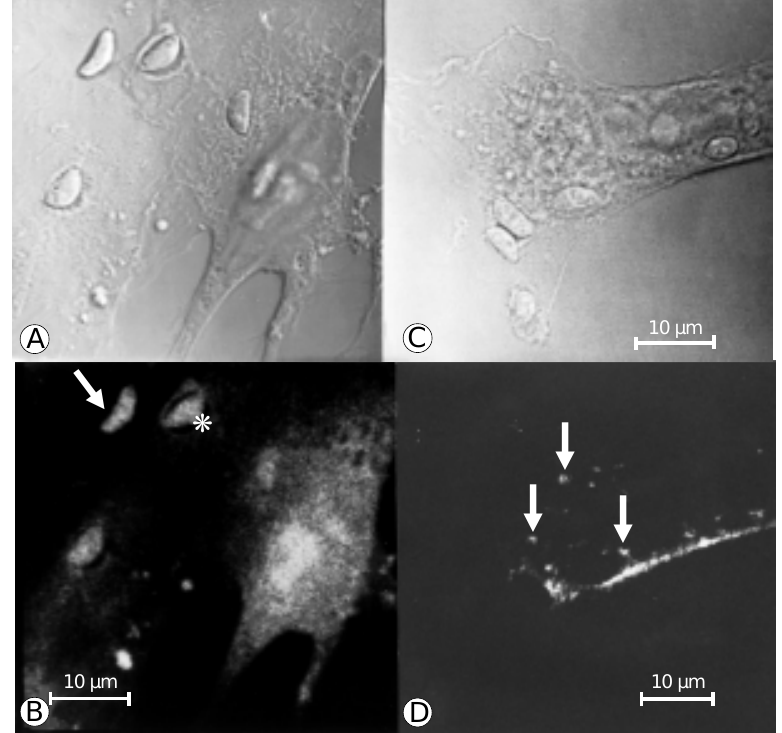
Figure 4 - Labeling of the Vero cell surface with DTAF and observation by differential interference microscopy (A,C) and CLSM (B,D). At early infection times (15 min) labeling is observed at sites of tachyzoite attachment (arrow in B), and in intravacuolar parasites (asterisk in B). After prolonged incubation times (24 h) no labeling of the parasites is observed. However, some cytoplasmic structures are labeled (arrows in D). Bar =